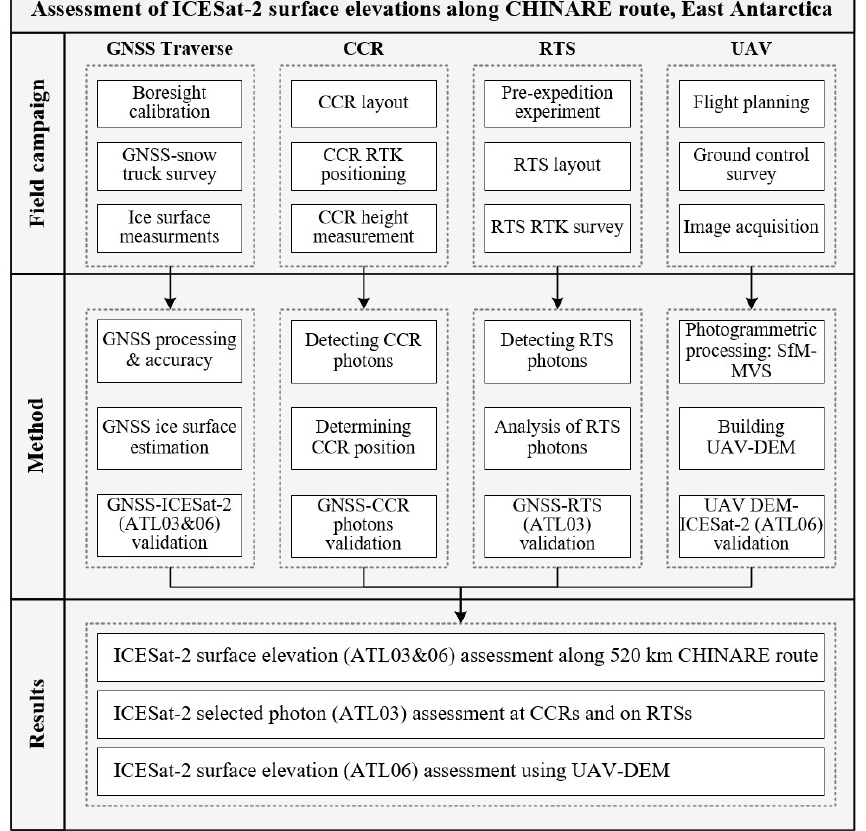
Figure 3. Flow chart for assessment of ICESat-2 ice sheet surface elevations along the CHINARE route, East Antarctica, as well as two validation sites, based on coordinated multi-sensor observations.